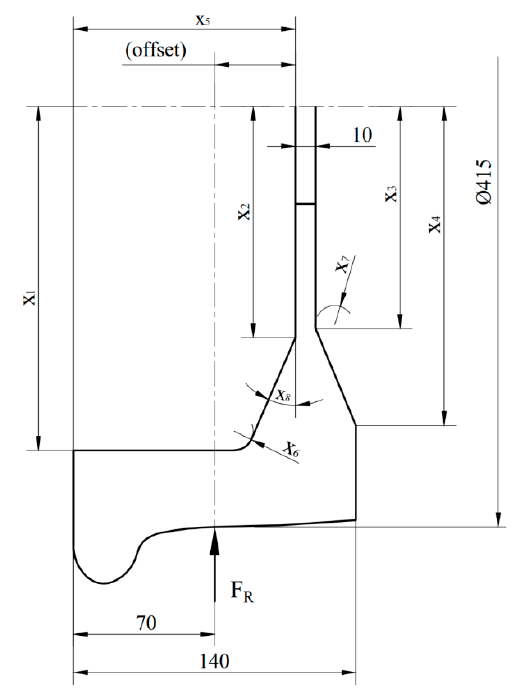
Figure 6. Rail wheel profile geometry with main dimensions (in mm) and design variables.